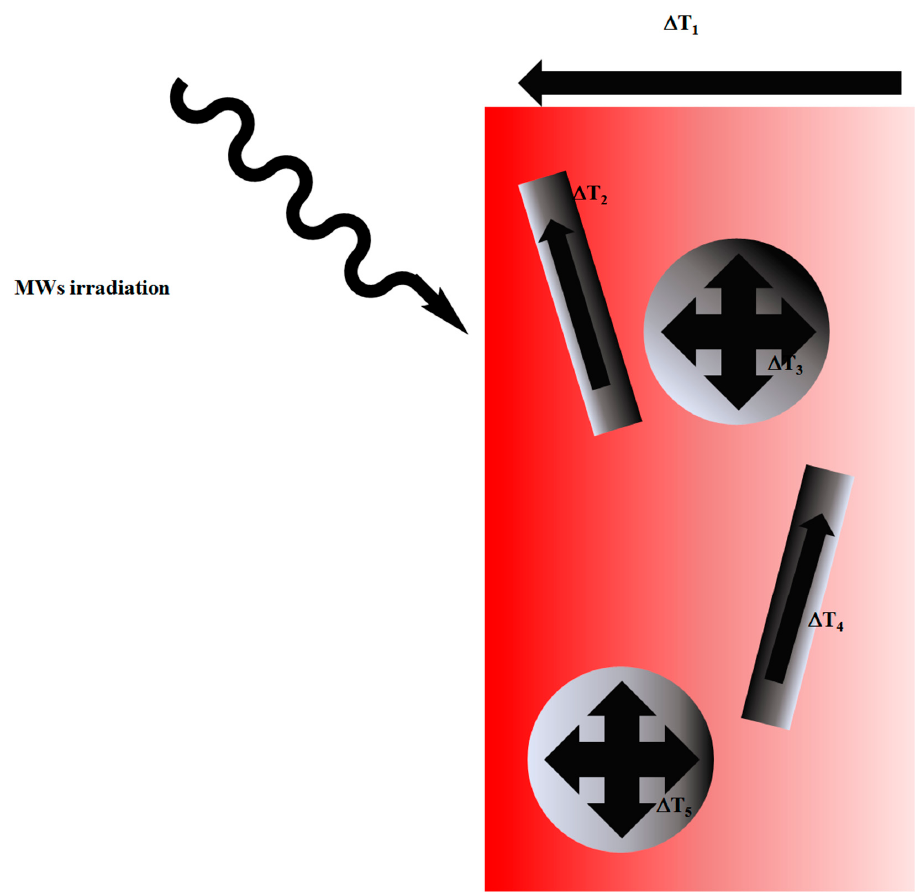
Figure 5. Inhomogeneity heating and multiple temperature gradients ( Δ T) inside a composite material with non-homogenous filler shapes. Deep colour intensity represents higher temperature regions inside the material.